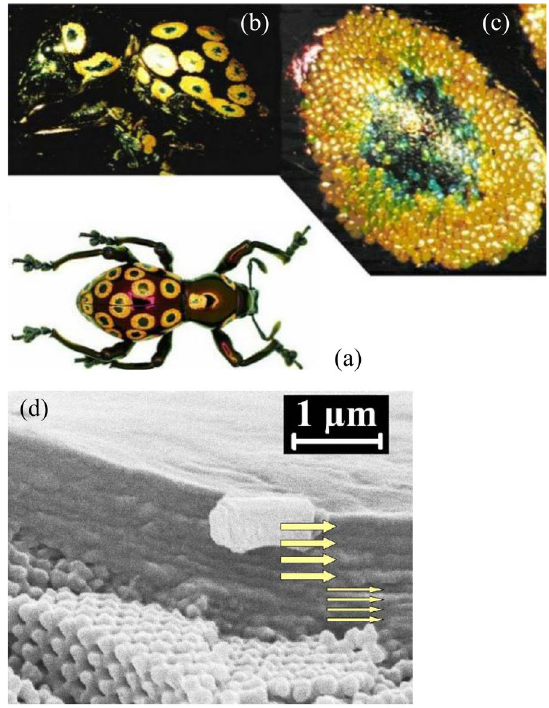
Figure 6 a and b Specimens of the weevil Pachyrrhynchus congestus pavonius ; c Orange dots; d Orange microstructure